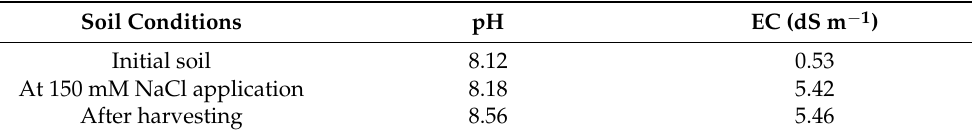
Table 3. Soil pH and EC during the